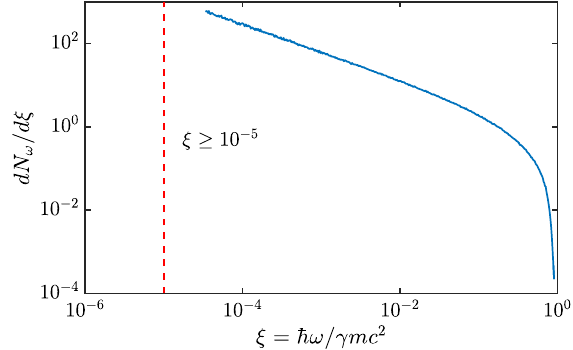
5. Photon spectrum (solid blue) for beam parameters of N ¼ 5 . 8 × 10 10 , E ¼ 30 GeV, σ 0 ¼ 1 μ m and σ local constant field approximation limit of validity (dashed red) is respected by all photons in the